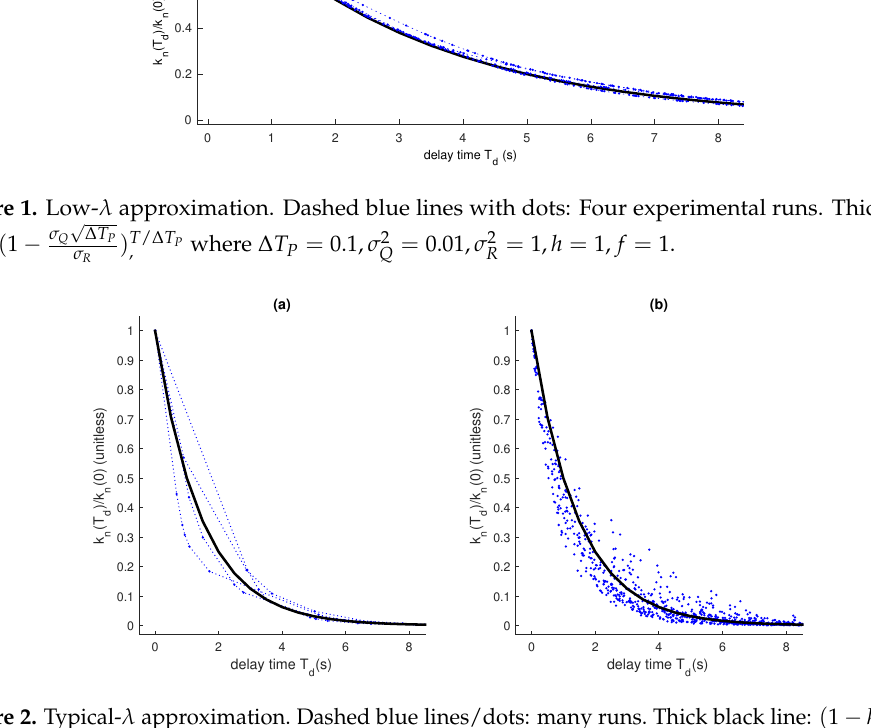
= 0.5, σ 2 = 1, h = 1, f = 1 ( a ) five runs; ( b ) 100 runs R Q